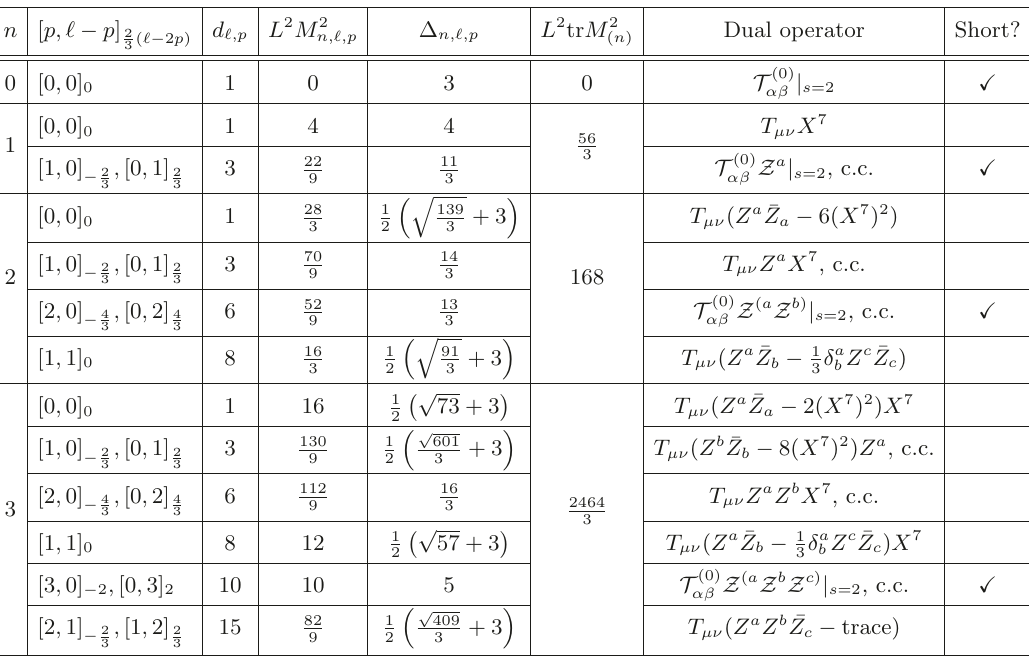
Table 1 . The spectrum of KK gravitons on the type IIA up to KK level n = 3. For each state, its SU(3) mass (3.1) and dimension computed from (3.2) is given. The trace of the mass matrix (4.6) at level n is also given, and the schematic form of the dual single-trace spin-2 operators.